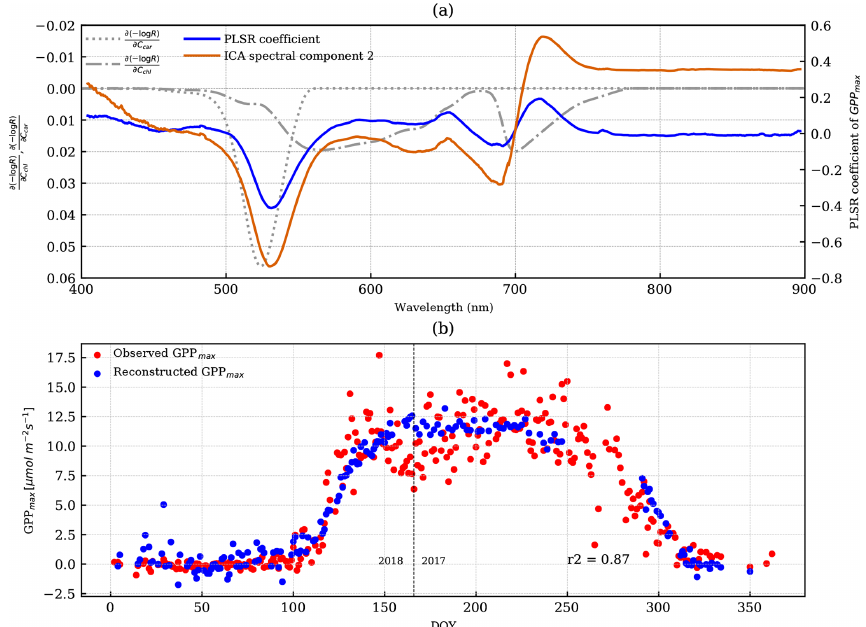
Figure 6. (a) The PLSR coefficient of reflectance with GPP max is the blue line. The overlaid dashed–dotted and dotted lines are chlorophyll and carotenoid Jacobians, respectively. The overlaid orange solid line is the second ICA spectral component, which was scaled to fit to the plot without a y axis. (b) The reconstructed GPP max (blue) by PLSR is overlaid with the observed GPP max (red). The vertical dashed line divides the observations from DOY for the years 2017 and